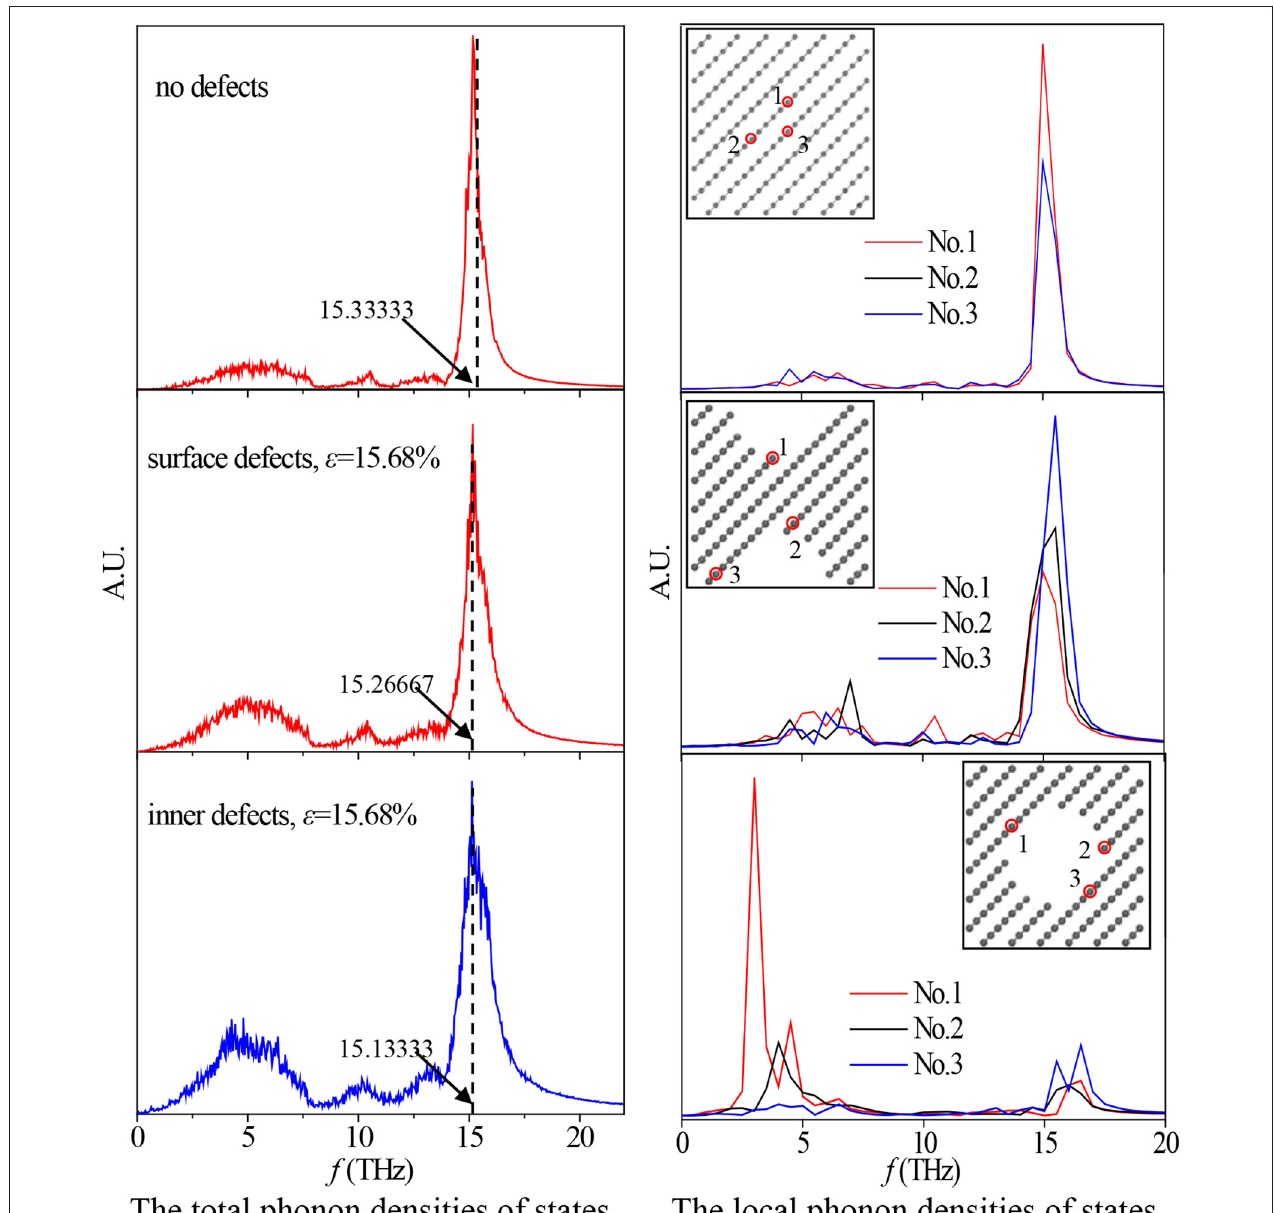
FIGURE 3 | The phonon density of states of different types of defective